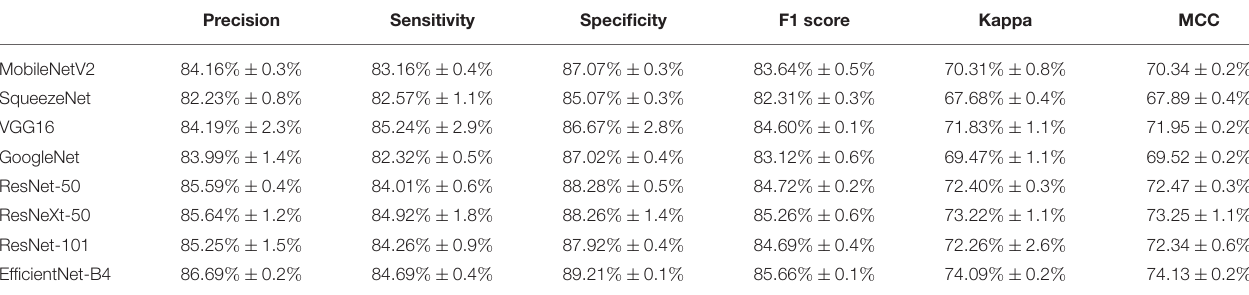
TABLE 1 | Image-level classification performance of different models on Dataset A+B.